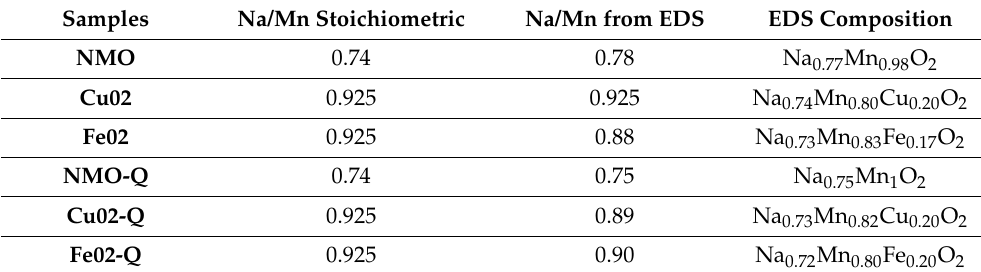
Table 2. Chemical compositions from the EDS analysis for all the synthesized samples.